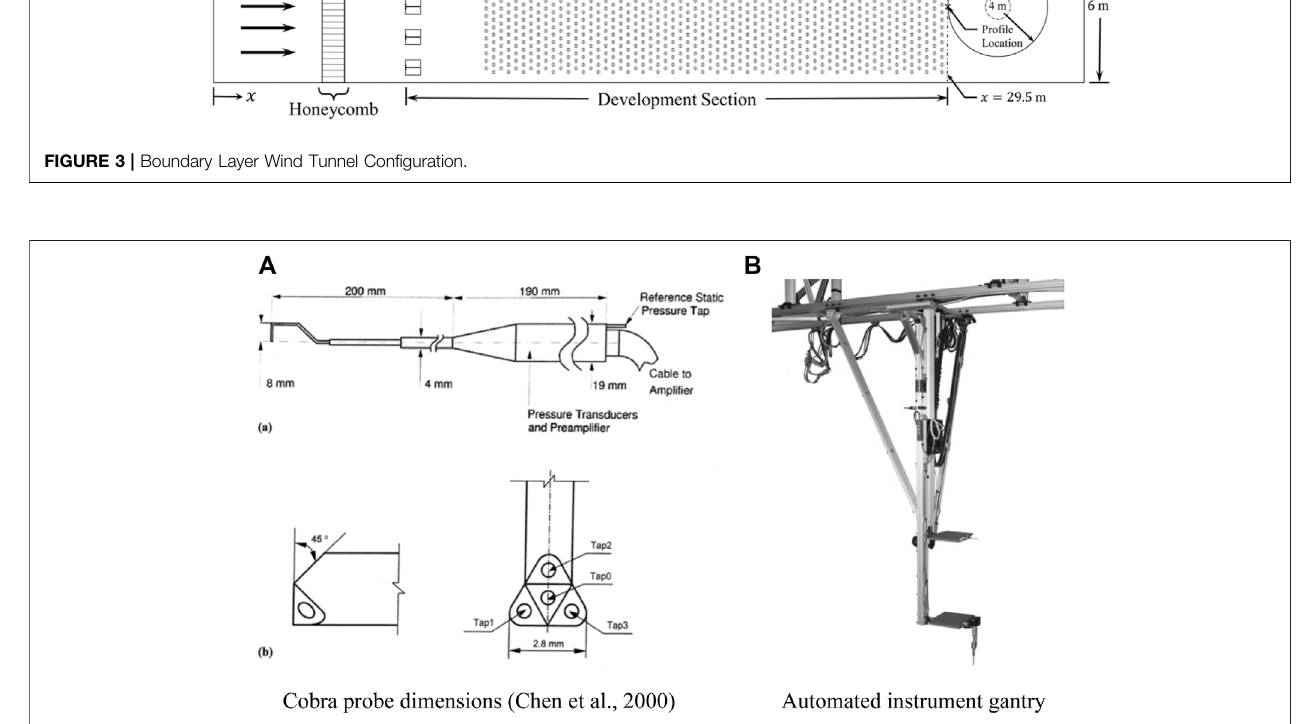
FIGURE 4 | Cobra probe instrumentation. (A) Cobra probe dimensions (Chen et al., 2000). (B) Automated instrument